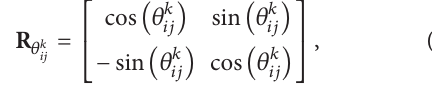
Figure 3: System model of transmitter 1 in a 2-user X channel configuration with